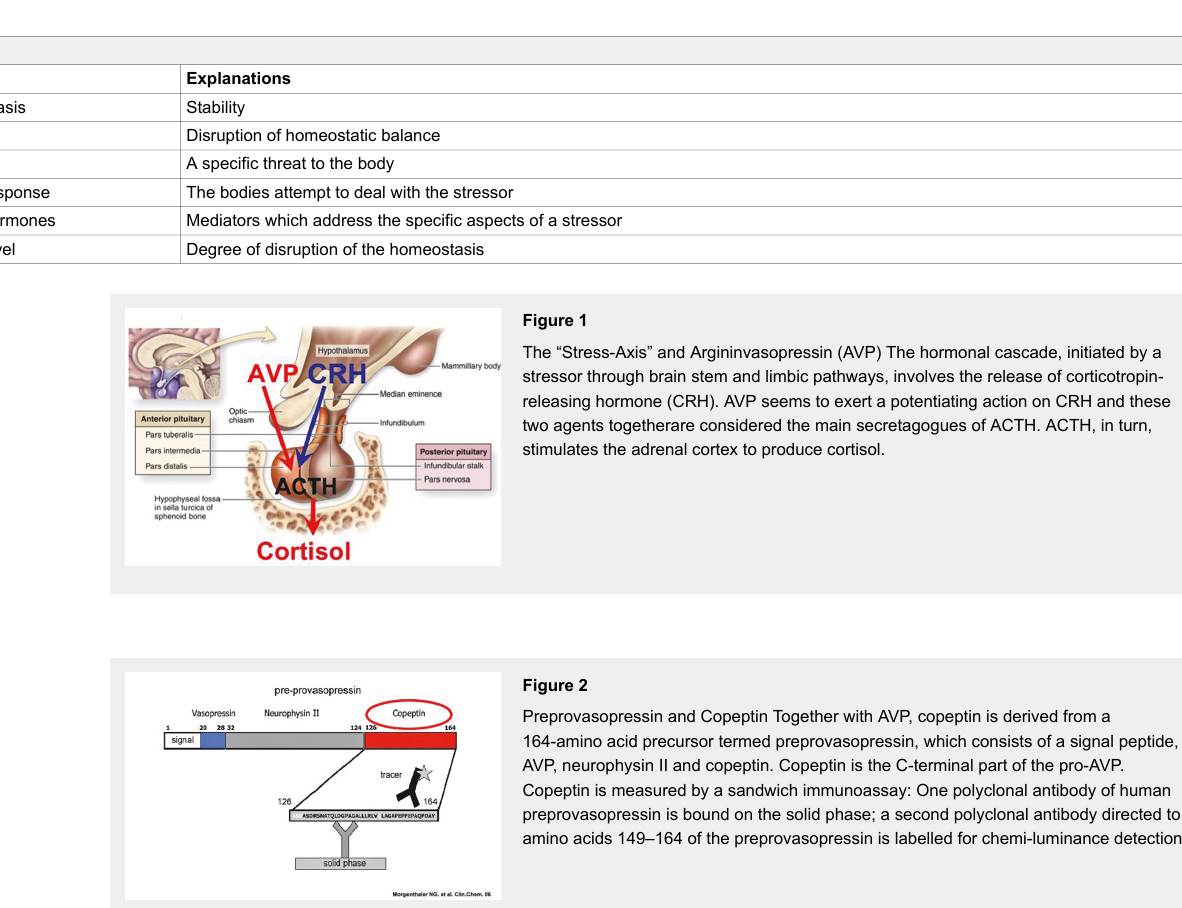
Preprovasopressin and Copeptin Together with AVP, copeptin is derived from a 164-amino acid precursor termed preprovasopressin, which consists of a signal peptide, AVP, neurophysin II and copeptin. Copeptin is the C-terminal part of the pro-AVP. Copeptin is measured by a sandwich immunoassay: One polyclonal antibody of human preprovasopressin is bound on the solid phase; a second polyclonal antibody directed to amino acids 149–164 of the preprovasopressin is labelled for chemi-luminance